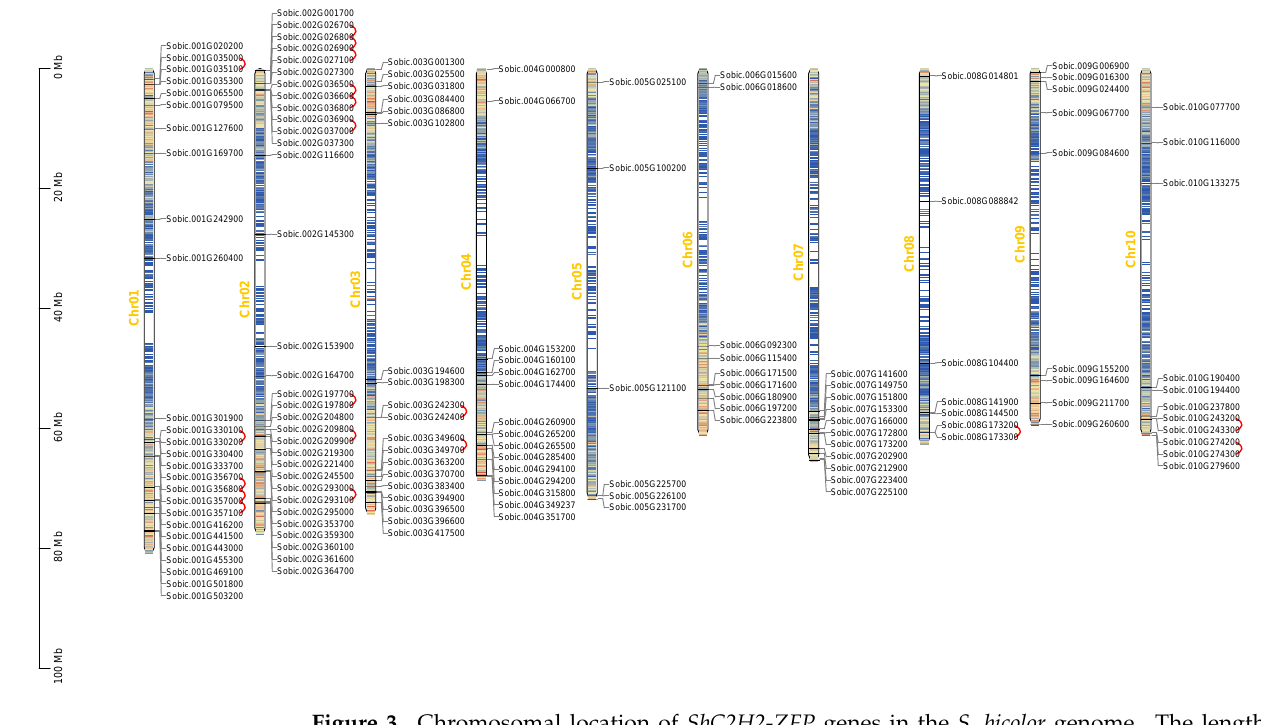
Figure 3. Chromosomal location of SbC2H2-ZFP genes in the S. bicolor genome. The length of chromosomes is measured in Mb. Genes of SbC2H2-ZFP are marked in black. Tandemly